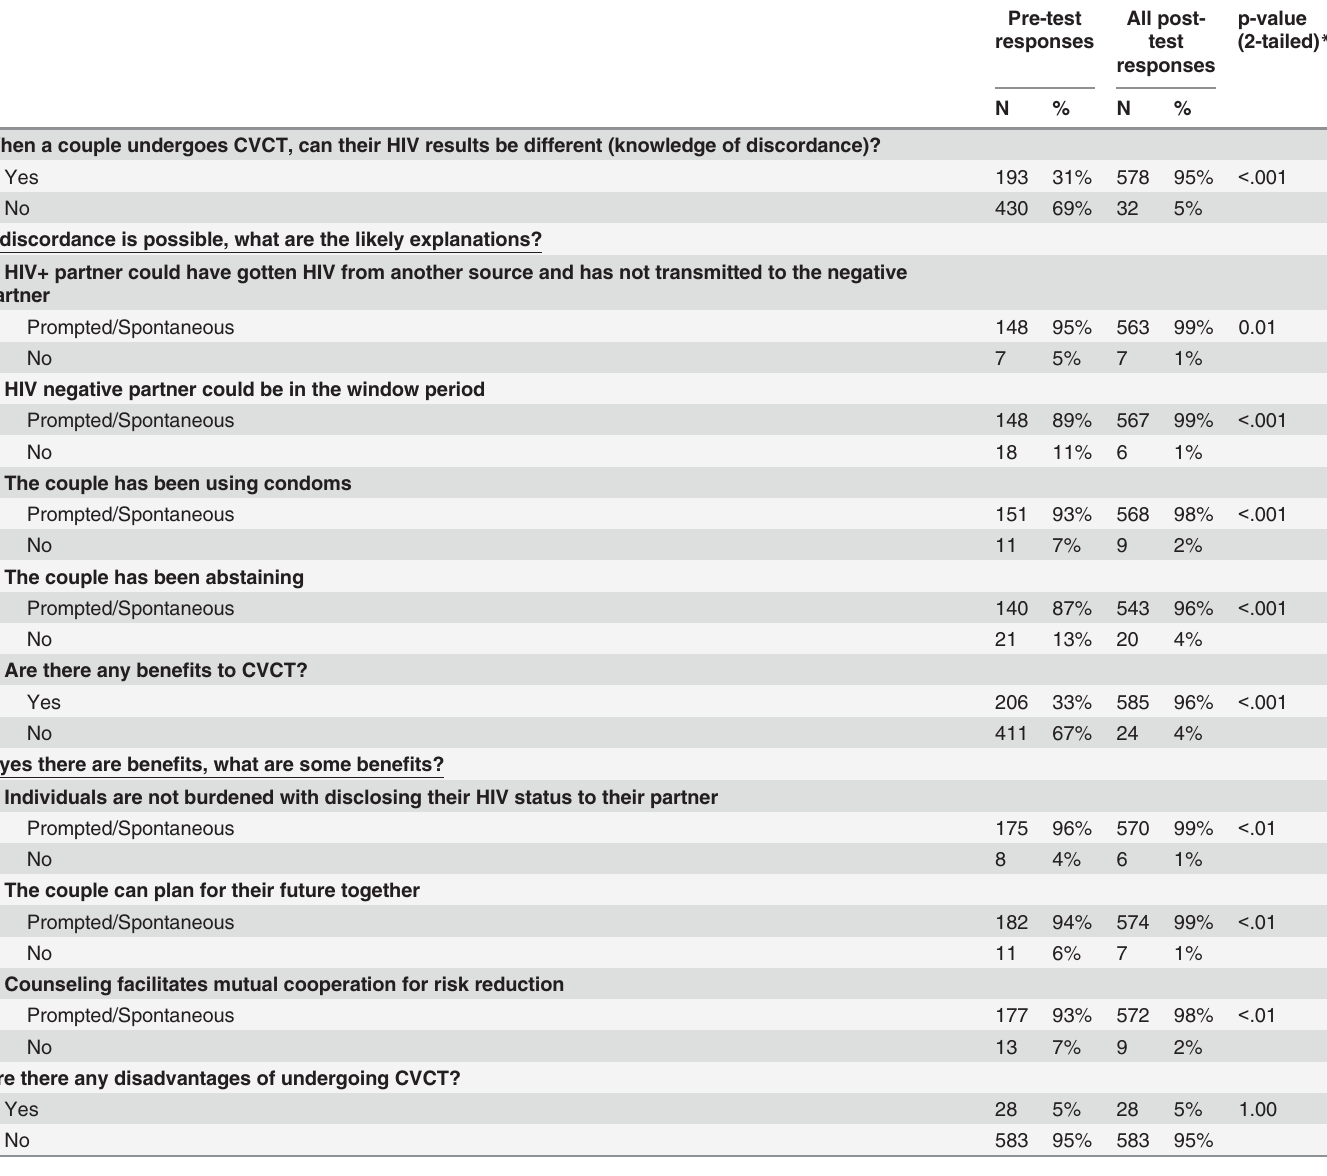
Table 2. Client knowledge and beliefs about serodiscordance and CVCT pre- and post-CVCT, Durban, South Africa,